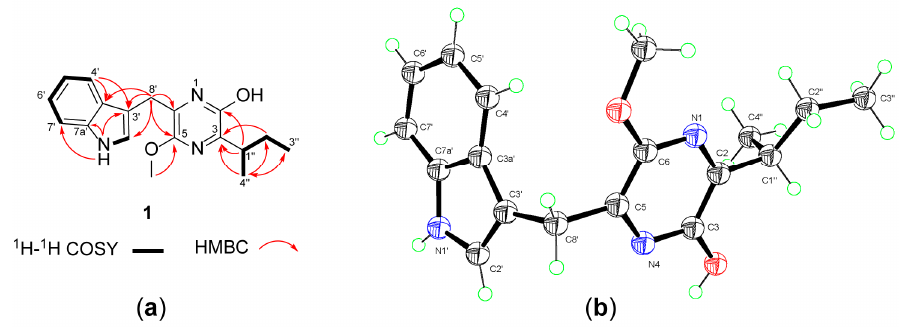
Figure 2. ( a ) The 1 H– 1 H COSY and key HMBC correlations of 1 . ( b ) X-ray crystallographic structure of 1 . Table 1. NMR spectroscopic data for compounds 1 − 3 in CDCl 3 . a